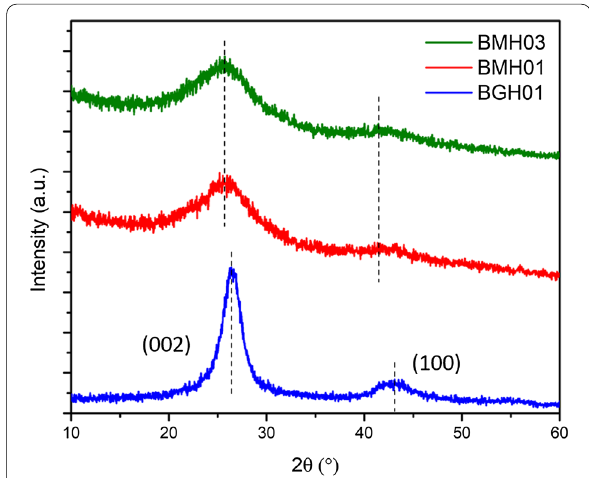
Fig. 2 The XRD patterns of polycrystalline BMH03 (green trace), BMH01 (red trace), BGH01 (blue trace), and BGH01. The broad peak of the BGH01 series at ca. 26.6° represents the (002) plane reflection of h‑BN and another broad peak at ca. 43.1° represents the unresolved reflection planes of h‑BN. Diffraction patterns of the BMH showed two broad reflections centered at around ~ 25.4° and ~ 42.4°. The XRD patterns of other BCNO series are shown in Additional file 1: Figure